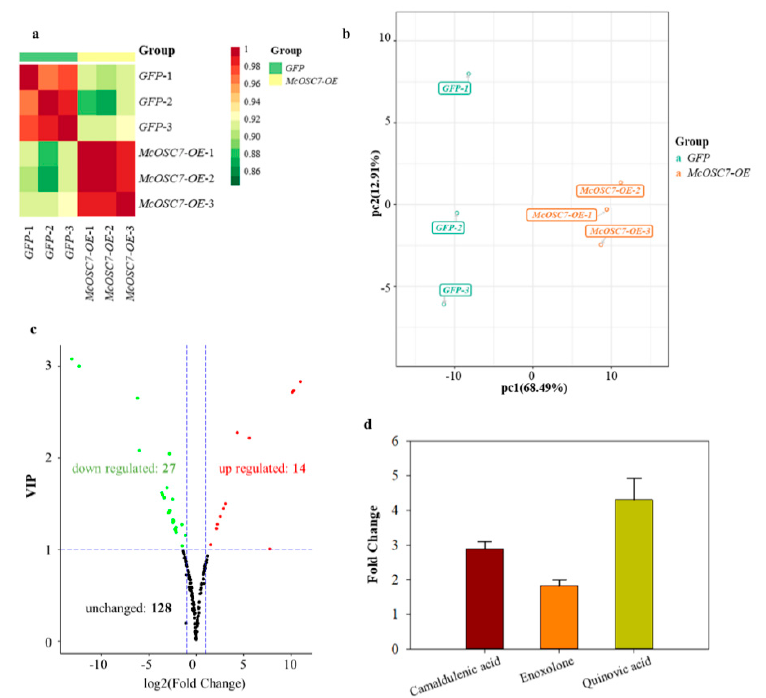
Figure 4. Widetarget metabolic data assessment and differentially accumulated metabolites (DAMs) analysis. ( a ) Pearson’s correlation coefficients among the McOSC7 - OE samples and quality control sample ( GFP ); ( b ) The quality control PCA score chart. The same color represents three biological replicates of the same sample; the x-axis represents the first principal component and the y-axis represents the second principal component; ( c ) Volcano plot showing the differential metabolites in GFP vs. McOSC7 - OE , VIP means variable importance in project; ( d ) Fold change of camaldulenic acid, enoxolone, and quinovic acid in McOSC7 - OE transgenic hairy roots, data represent the mean ± SD of three independent